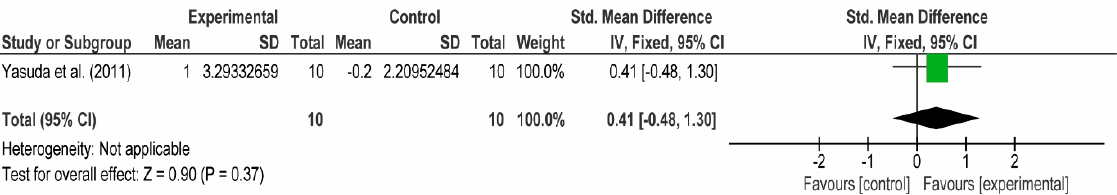
Figure 8. The effect size of 6-weeks of high-intensity training on the triceps brachii muscle CSA.